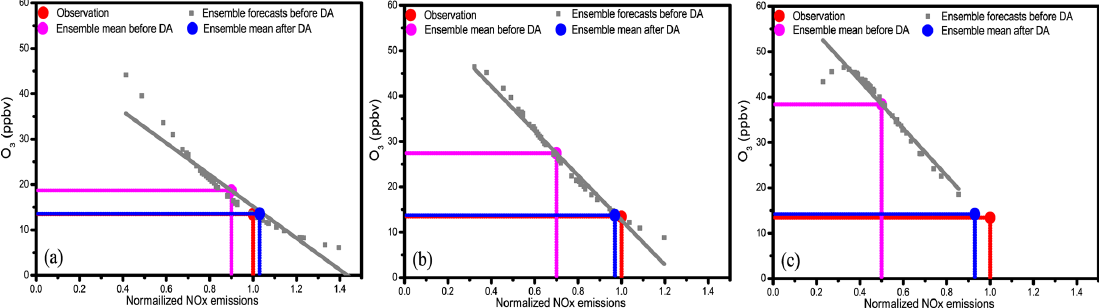
Figure 7. (a–c) O 3 concentrations (ppbv) and NO x emissions (no unit, normalized by the true NO x emission) before and after data assim- ilation and their ensemble samples before DA 08:00LT on 12 August 2008 in the three ideal ozone data assimilation experiments with the prior NO x emissions underestimated by 10% (a) , 30% (b) , and 50% (c) , respectively. The magenta dot, the gray squares, the gray line, the red dot, and the blue dot represent the same information as in Fig.